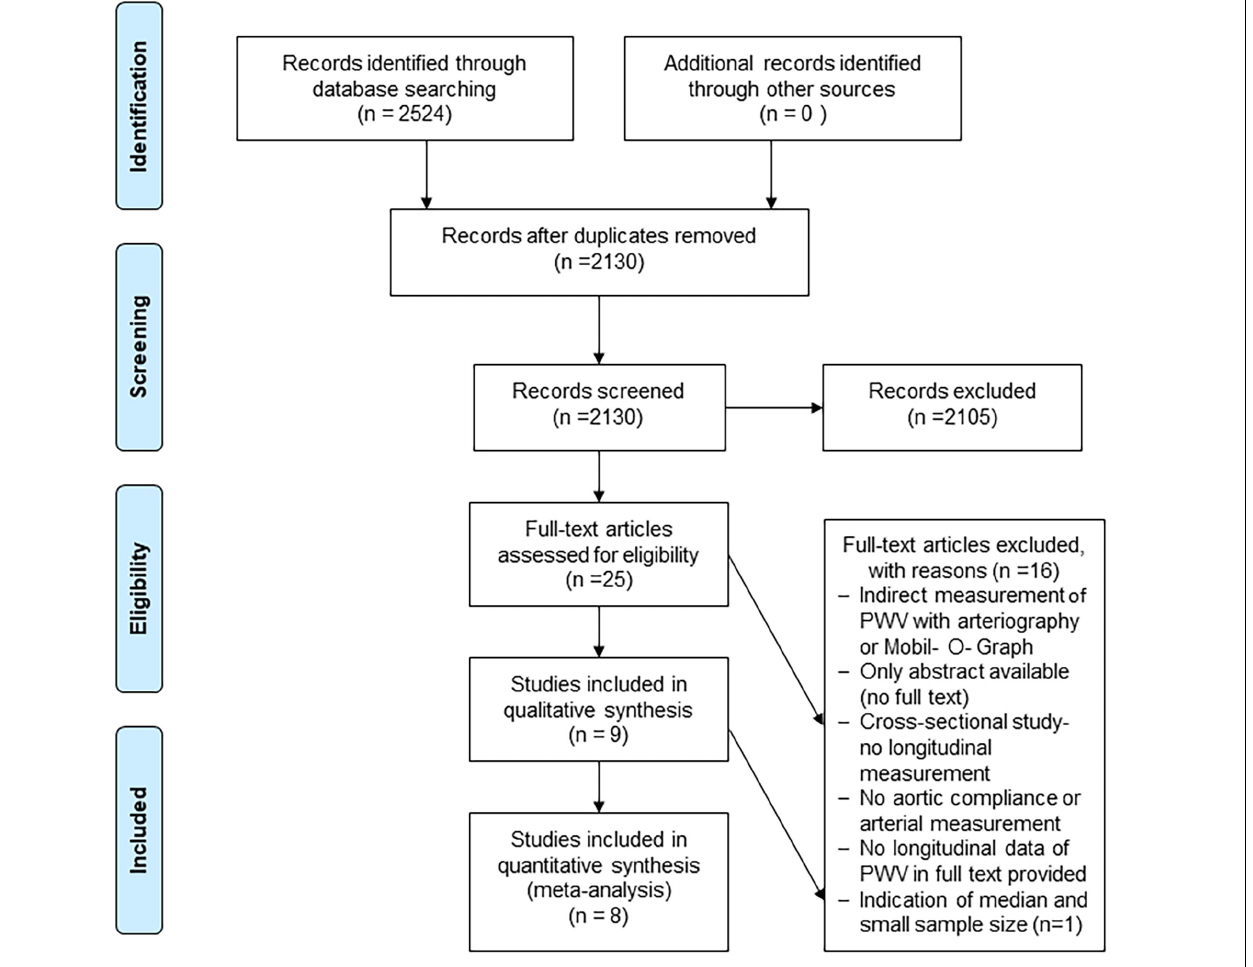
FIGURE 1 | Flowchart for study inclusion, adapted from the PRISMA statement. Flow chart illustrating the study search, screening and selection